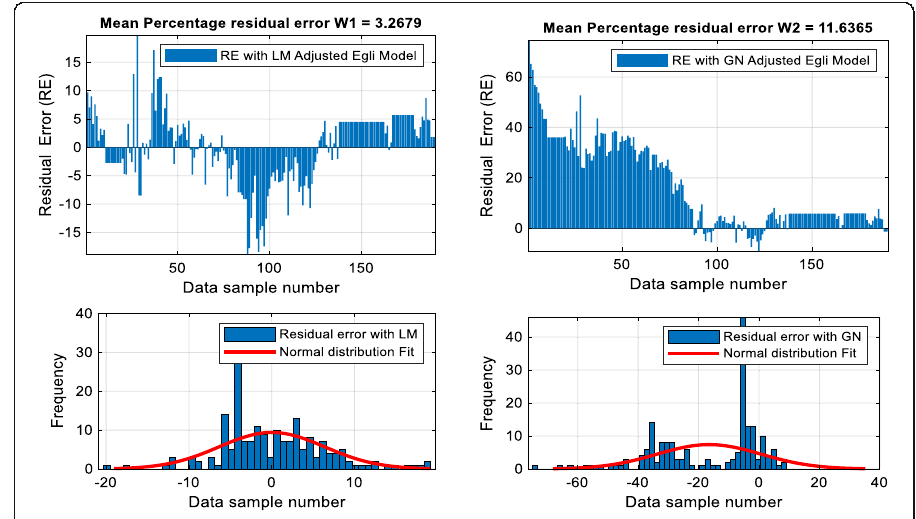
Fig. 10 Measured propagation loss estimation and their error distribution statistics using classical Egli model and adapted Egli model for Cell_3